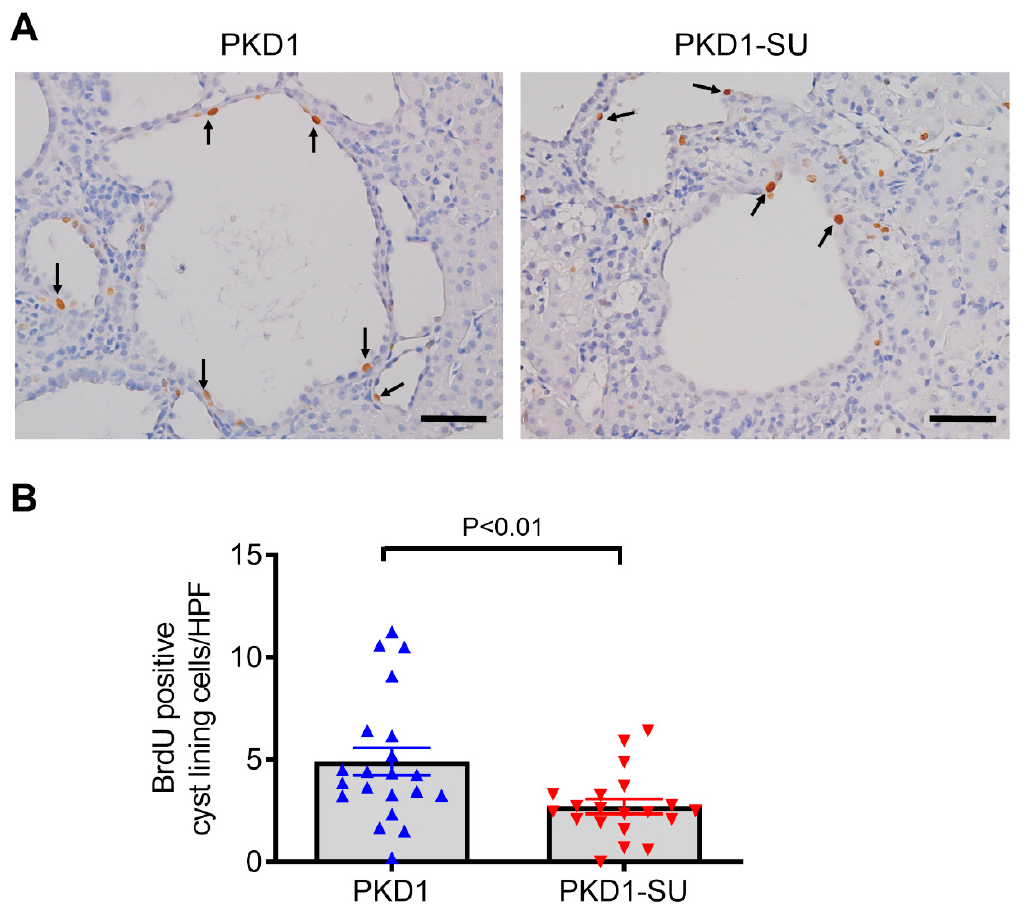
Figure 3. Suramin treatment inhibits the proliferation of cyst-lining epithelial cells in Pkd1 miR Tg mice. ( A ) Immunostaining for BrdU incorporation in kidney sections from Pkd1 -miR Tg mice in vehicle- and suramin-treated groups. Arrows indicate BrdU-positive cyst lining epithelial cells. Scale bar, 50 µm. ( B ) Quantitative image analysis showed a significant reduction ( p < 0.01) in the number of BrdU-positive cells in the suramin-treated Pkd1 -miR Tg mice (n = 20) compared with the vehicle-treated mutant mice (n = 21) using an unpaired, two-tailed t -test. Data are mean ± SEM.